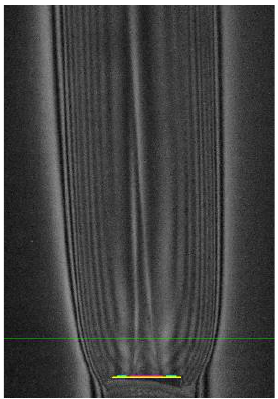
Figure 2. Hilbertogram of the co- current fuel flow Н 2 (65%) + N 2 (35%) escaping into the O 2 flow: G-channel — λ 2 = 537 nm, mentioned cross-section y = 6 mm.